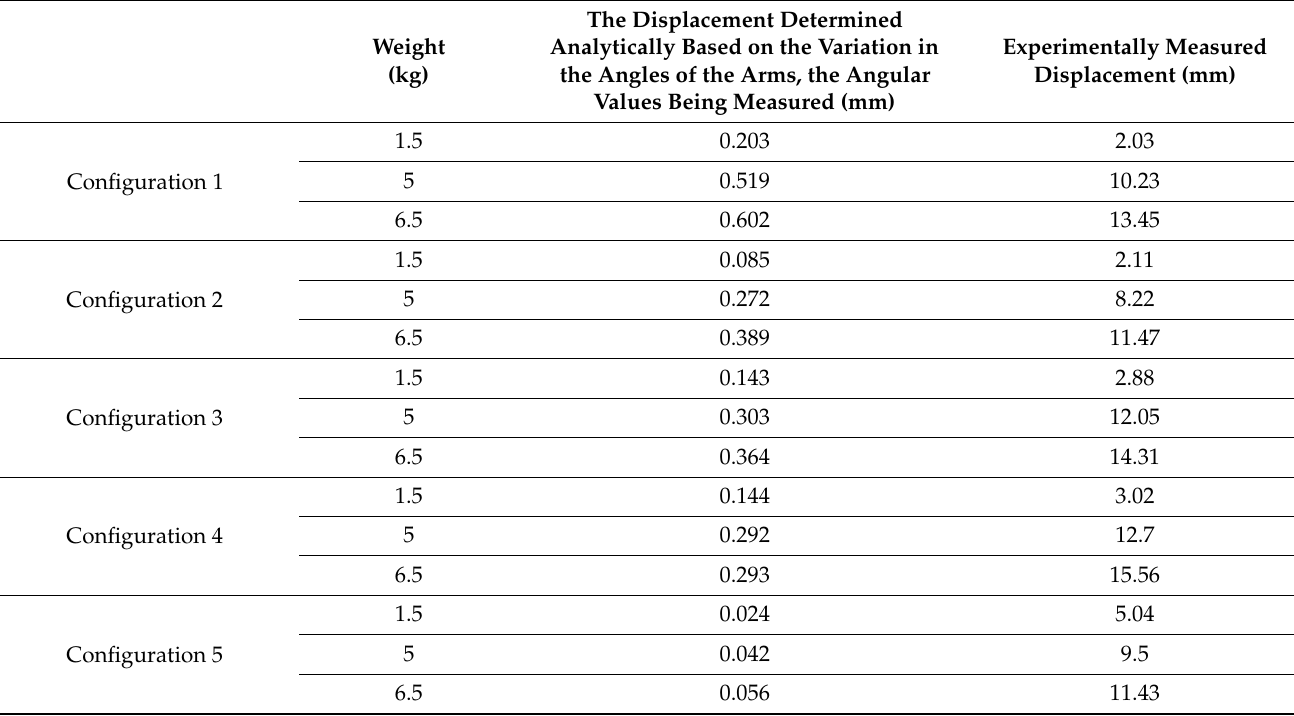
Table 7. Effector displacement calculated based on the axial deformation of the experimentally measured motors.